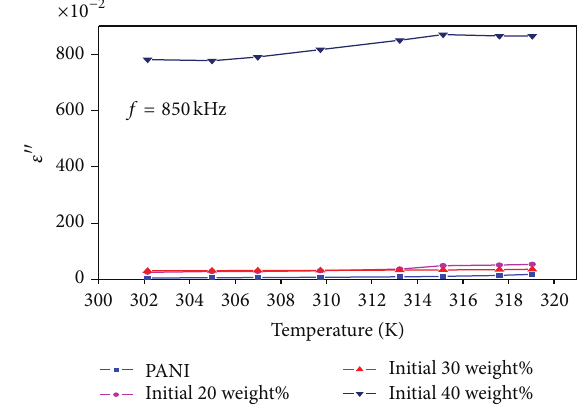
Figure 3: Dielectric loss ( 𝜀 󸀠󸀠 ) versus temperature at fixed frequency for pure polyaniline and PANI/V 2 O 5 composites (different weight %).